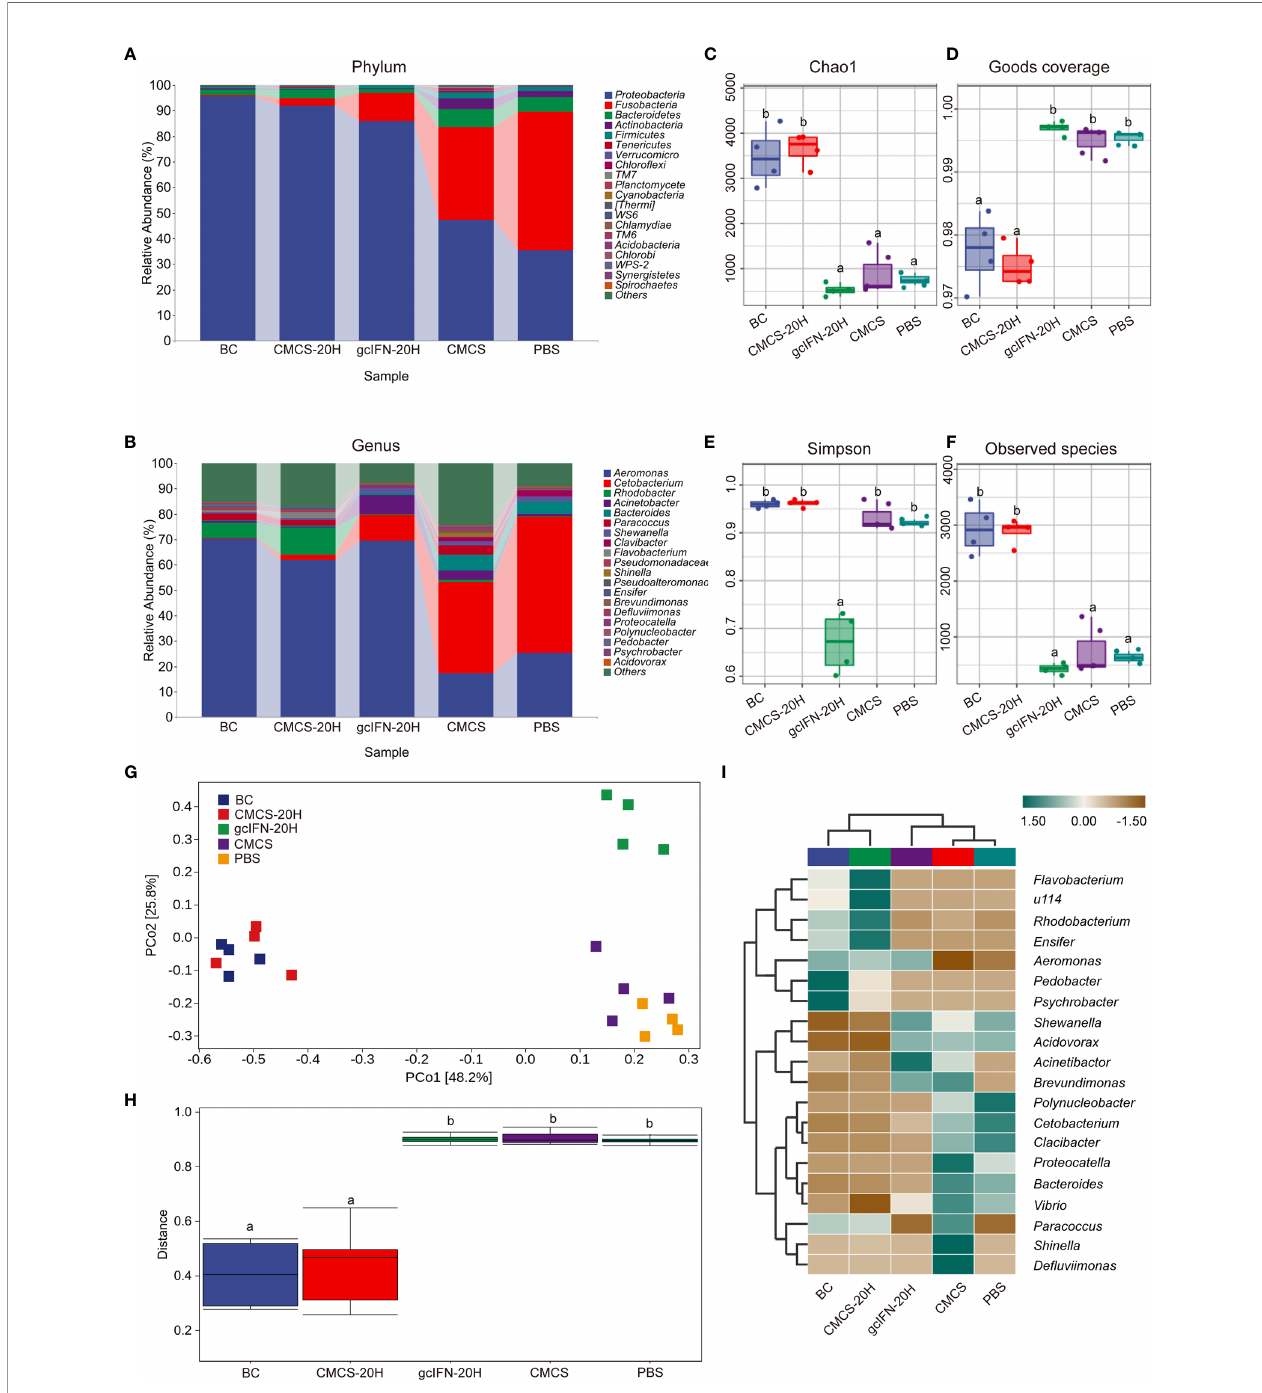
FIGURE 8 | 16S rRNA amplicon-sequencing analysis of intestinal microorganisms in grass carp. (A, B) Taxonomic composition analysis at phylum and genus levels. Grass carp fed with common fodder and unchallenged with A . hydrophila were used as blank control (BC). Each color bar represents one phylum and genus. The height of bar represents the phylum or genus relative abundance. “ Others ” includes the sum of different genera which are less than 1% in the sample. (C – F) Chao1, Goods coverage, Simpson, and Observed species were analyzed. (G) Principal coordinates (PCo) analysis. (H) Permutational multivariate analysis of variance (PERMANOVA) analysis. (I) Heatmap of hierarchy cluster results for the relative abundance of all samples at genus level. The sample information is shown along the horizontal axis. Annotations are shown along the vertical axis on the right. The genera clustering tree is shown along the vertical axis on the left. The sample clustering tree is shown above. The color represents the Z -score, which is the standardized relative abundance. Data are presented as means ± SD ( n = 4). Different lowercase letters in each group (a and b) denote signi fi cant variations suggested by the Kruskal-Wallis statistics followed by the Dunn ’ s multiple comparison (p <